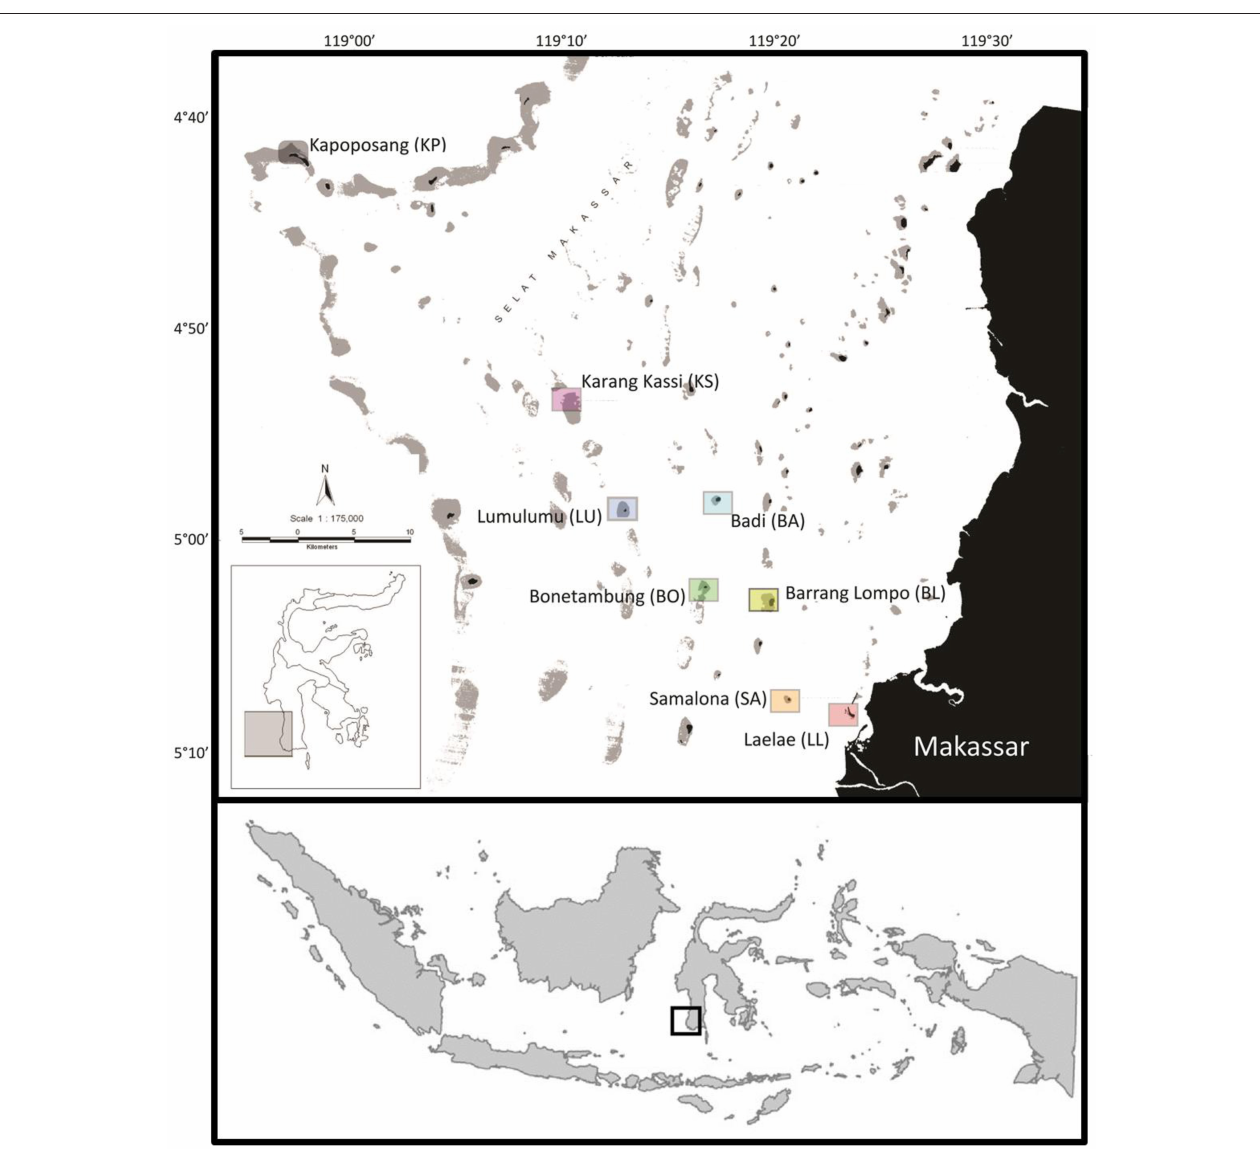
FIGURE 1 | Map of the Spermonde Archipelago, Indonesia indicating the sampling sites. The lowest box indicates southwest Sulawesi relative to Indonesia and the middle inset indicates the location of the Spermonde Archipelago off southwest